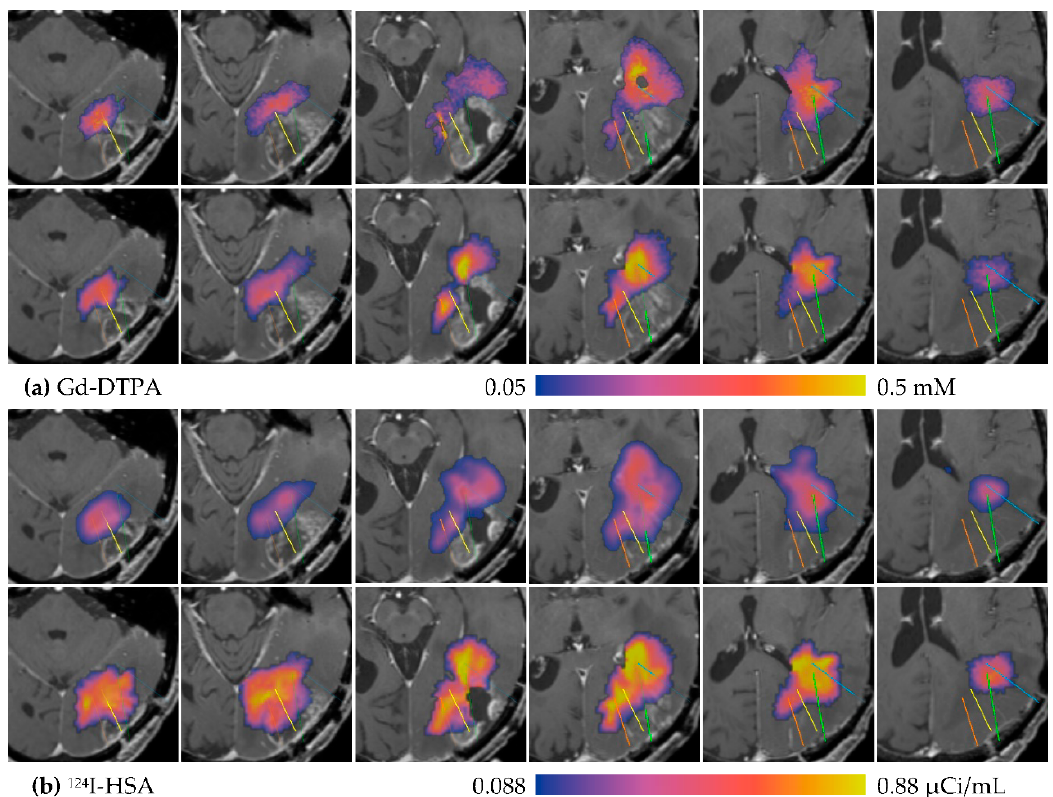
Figure 6. Comparison of measured concentration (top row) with the prediction from simulation (bottom row) after 24 h of infusion in MR1-1 Patient 7. Gd-DTPA distribution (in color, overlaid on pre-infusion T1-weighted MRI, six axial slices, 10 mm apart). ( a ) Measured (Top) vs. simulated (Bottom) Gd-DTPA concentration. ( b ) measured (Top) vs. simulated (Bottom) 124I-HSA concentration.